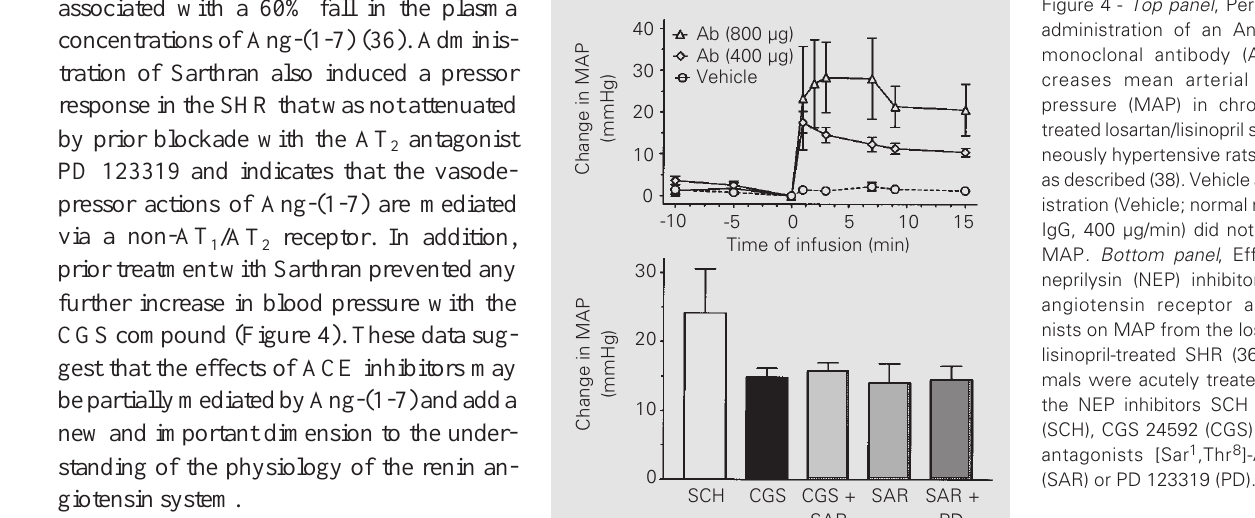
Figure 4 - Top panel , Peripheral administration of an Ang-(1-7) monoclonal antibody (Ab) in- creases mean arterial blood pressure (MAP) in chronically treated losartan/lisinopril sponta- neously hypertensive rats (SHR) as described (38). Vehicle admin- istration (Vehicle; normal mouse IgG, 400 µg/min) did not affect MAP. Bottom panel , Effect of neprilysin (NEP) inhibitors and angiotensin receptor antago- nists on MAP from the losartan/ lisinopril-treated SHR (36). Ani- mals were acutely treated with the NEP inhibitors SCH 39370 (SCH), CGS 24592 (CGS) or the antagonists [Sar 1 ,Thr 8 ]-Ang II (SAR) or PD 123319